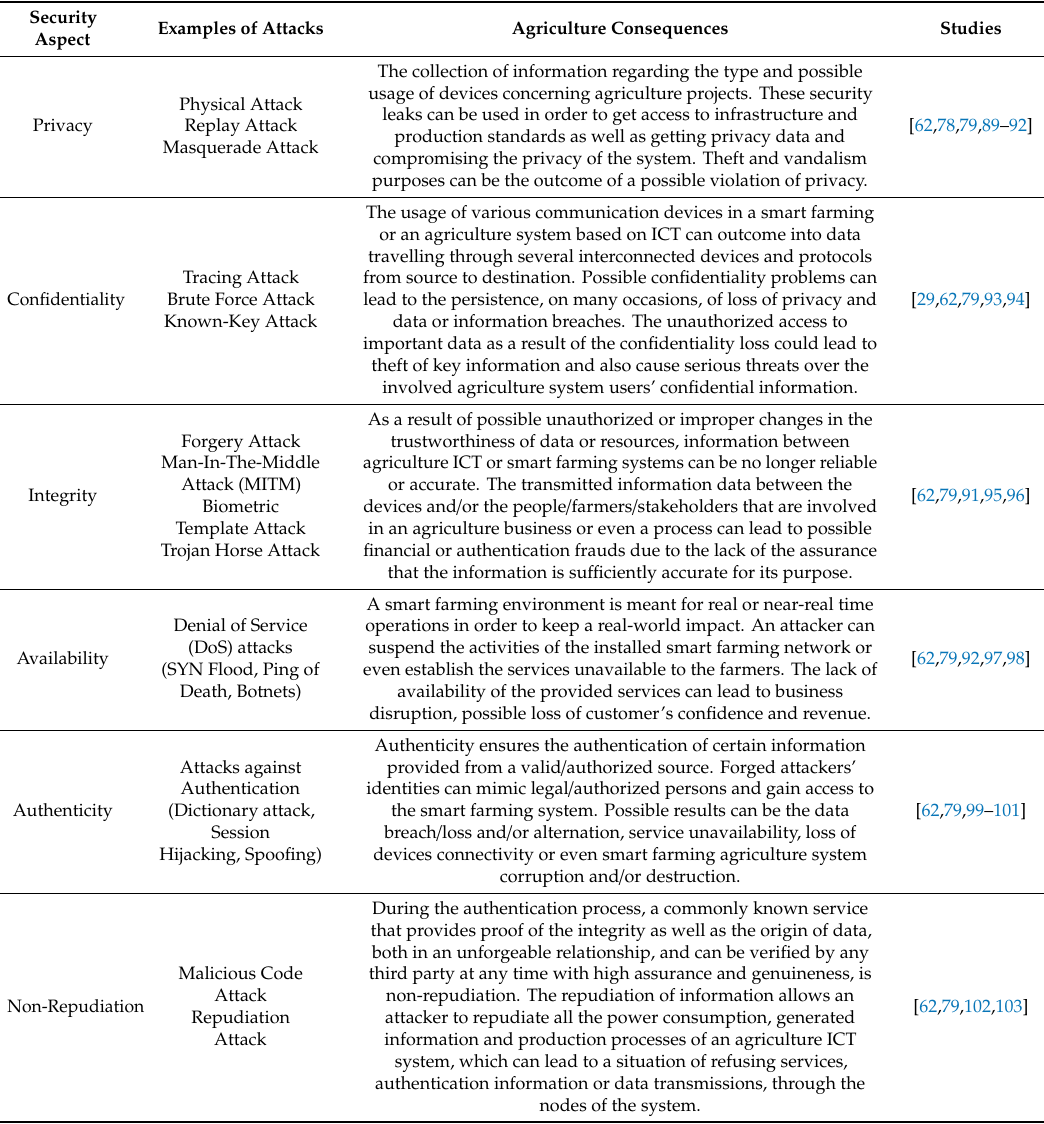
Table 2. Overview of possible attacks per security aspect in agricultural